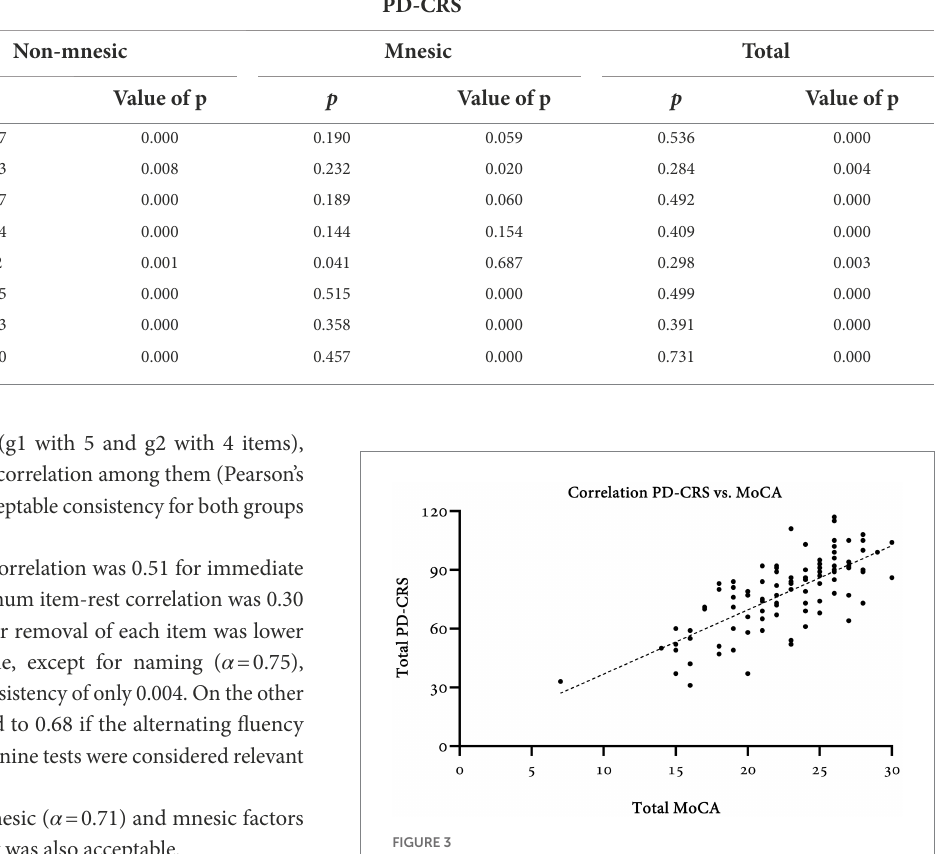
TABLE 4 Correlations for total and subtotal scores of MoCA with PD-CRS.